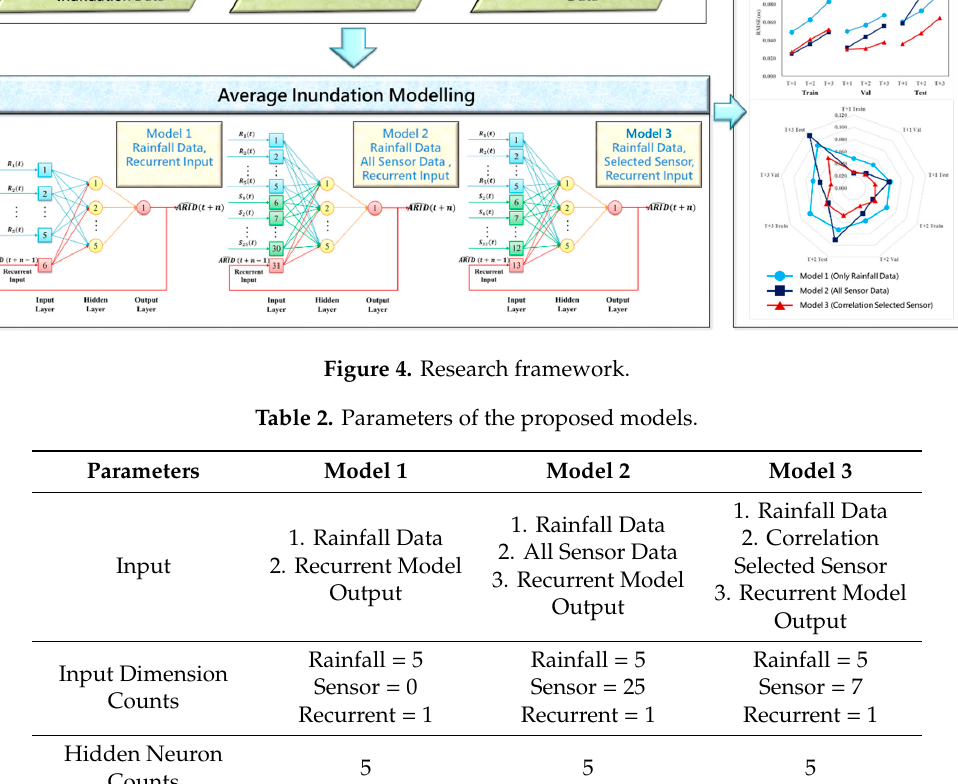
Table 2. Parameters of the proposed models. 187